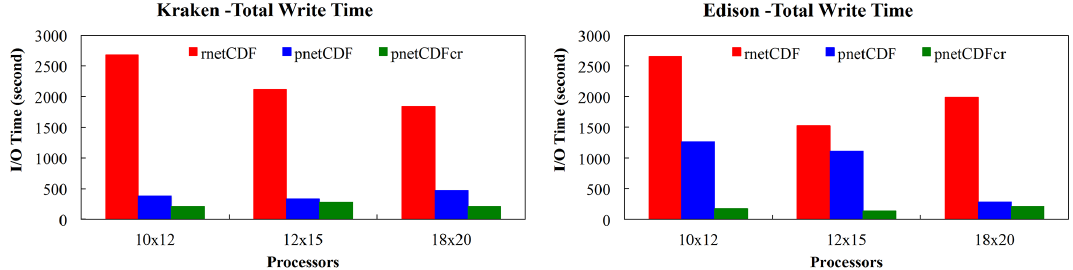
Figure 12. Total write time in a 1-day CMAQ simulation by different I/O approaches on a 4km EUS domain with stripe size of 2MB and stripe count of 11 (Kraken left and Edison